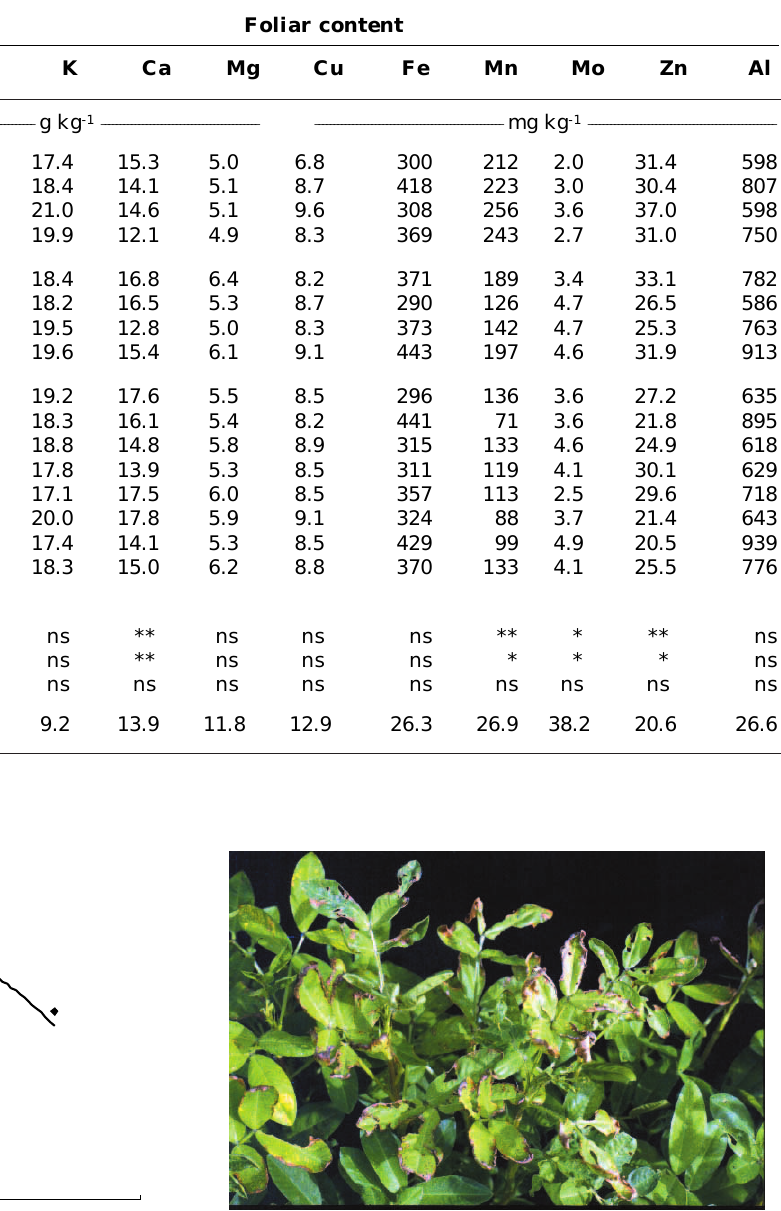
Figure 4. Molybdenum deficiency symptoms in